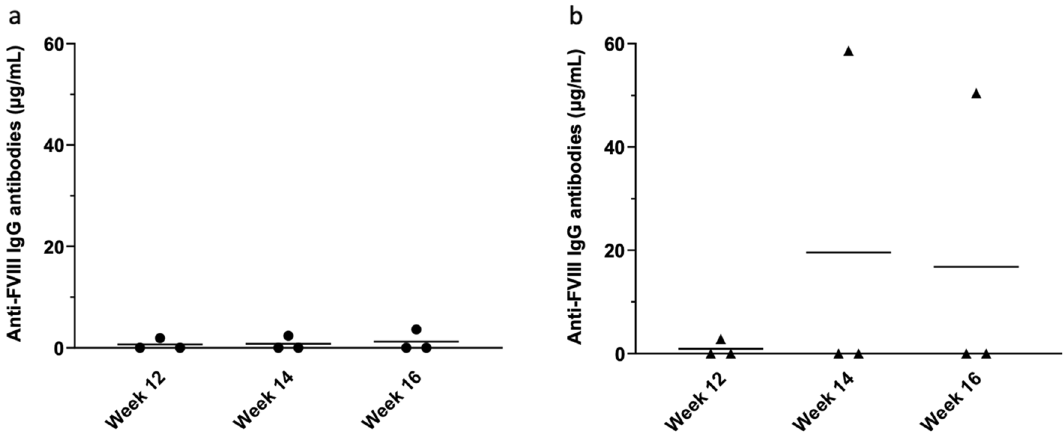
Figure 3. Anti-FVIII antibody development pattern of each mouse in the treatment group after receiving weekly injection of ( a ) FVIII + IVIG or ( b ) FVIII alone for the additional duration of 4 weeks following 12 weeks of co-injection therapy. Plasma samples were collected and anti-FVIII antibody levels analysed as described in Fig. 2. Horizontal bars represent